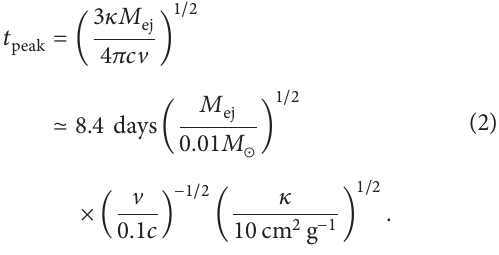
Figure 1: Bolometric light curves of a NS-NS merger model (red, 𝑀 𝑀 ej = 0.01 ⊙ [57, 58]) and a wind model (green, compared with a light curve of Type Ia SN model (gray, 𝑀 ej = 1.4 𝑀 ⊙ ). The black dashed line shows the deposition luminosity by radioactive decay of 𝑟 -process nuclei ( 𝜖 dep = 0.5 and 𝑀 ej = 0.01𝑀 ⊙